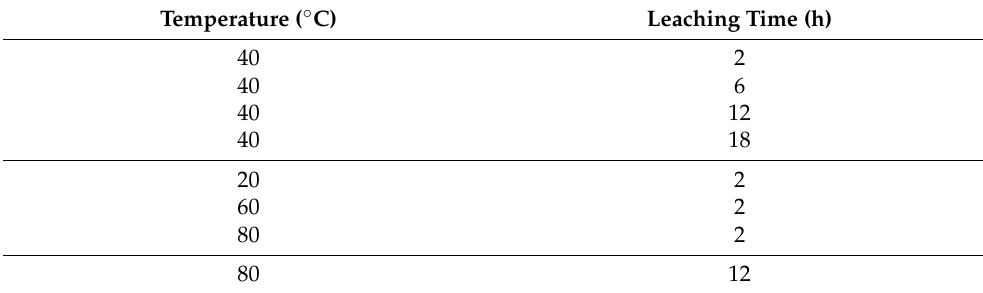
Table 2. Leaching temperatures and times in 5 mol/L